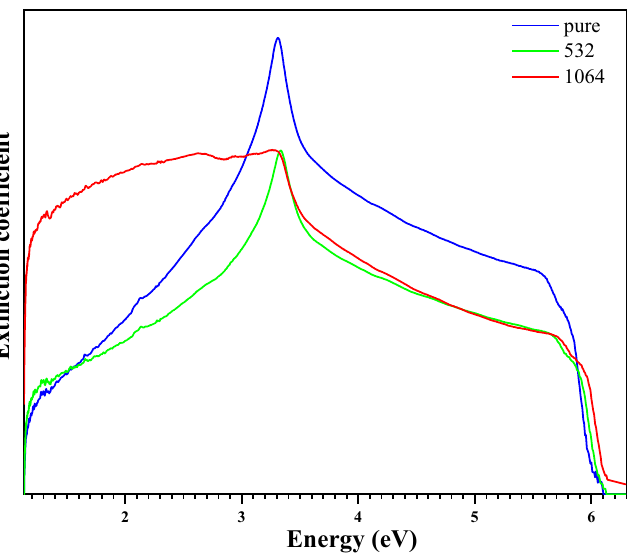
Figure 11. Calculated extinction coefficient plot before (blue line) and after irradiation with laser beams (red and green line) for ZnO